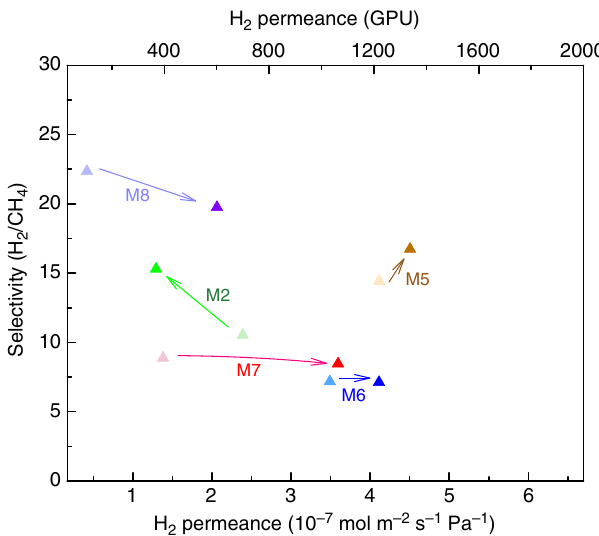
Fig. 8 The evolution of gas separation performance after different ozone treatments. Permeance data for membrane M8 is at 200 °C, and all other (M2, M5, M6, and M7) is at 150 °C. Light and dark markers represent the gas performance from the intrinsic defects and the ozone-treated graphene,